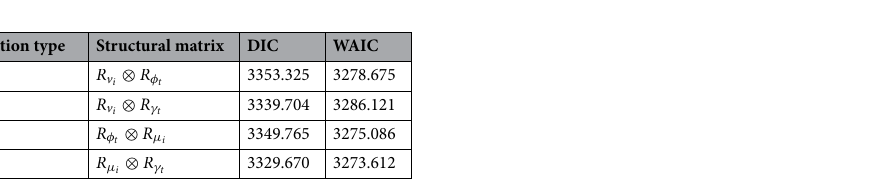
Table 5. The selection information for the four spatio-temporal interaction types on level 1 of the model